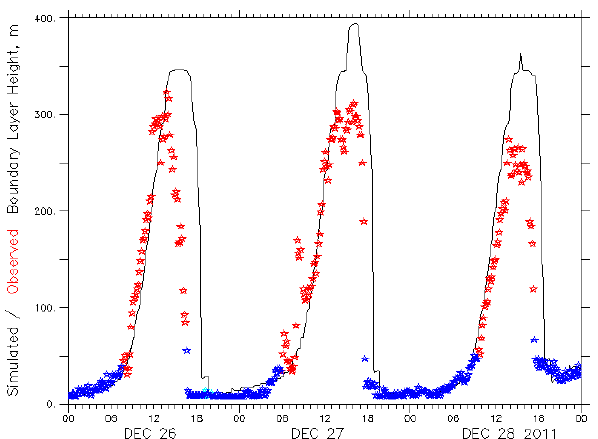
Figure 6. The boundary layer height at Dome C as a function of Local Time LT (Universal Time UT + 8h). Red (blue) stars: sodar observations during convective (stable) situations (Argentini et al., 2013). Dark line: MAR mixed layer depth, computed as the level where the turbulent kinetic energy amounts to 5% of the turbulent kinetic energy in the lowest layer of the